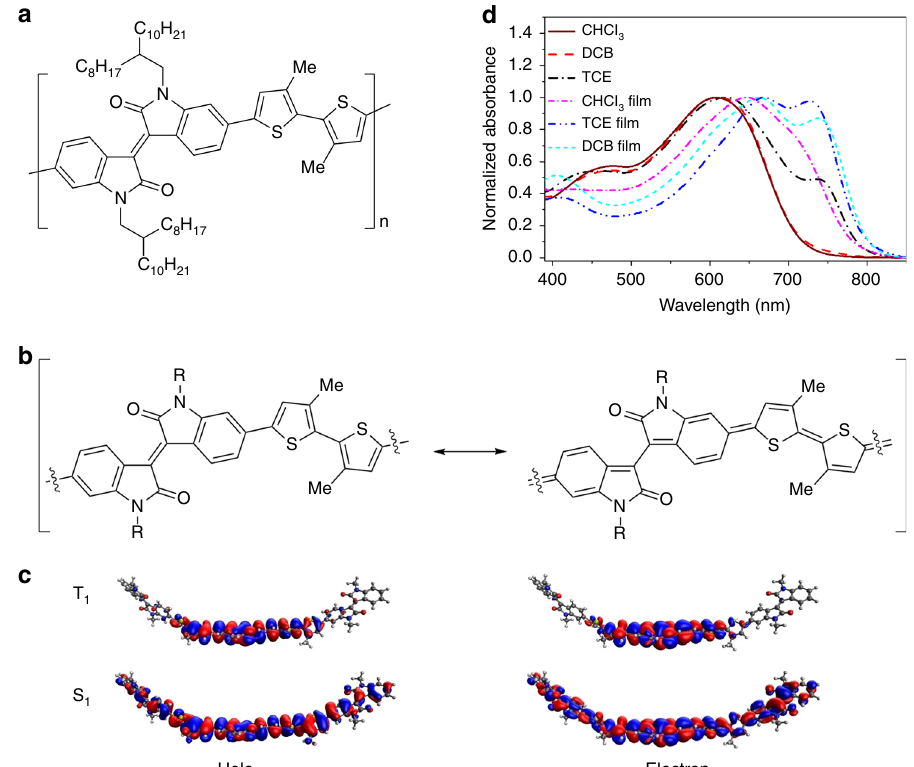
Fig. 1 Structure and energetics analysis. a Structure of isoindigo-based low-bandgap polymer IIDDT-Me. b Aromatic and quinoidal resonance structures of IIDDT-Me. c Natural transition orbital analysis of the electron and hole states for the singlet and triplet. d Normalized UV − Vis absorption spectra of IIDDT- Me in the TCE, DCB, CHCl 3 solution, and fi